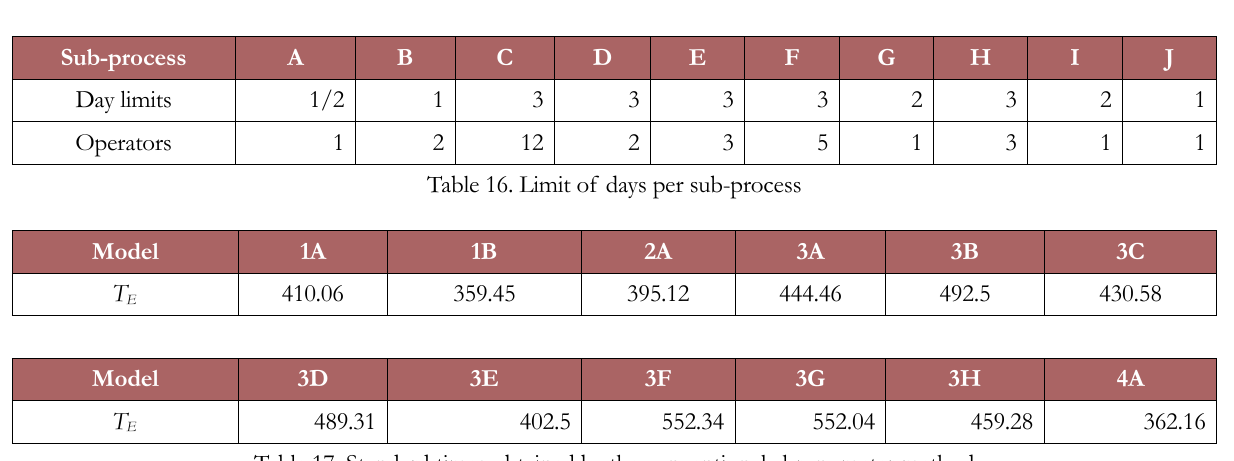
Table 17. Standard times obtained by the conventional chronometer